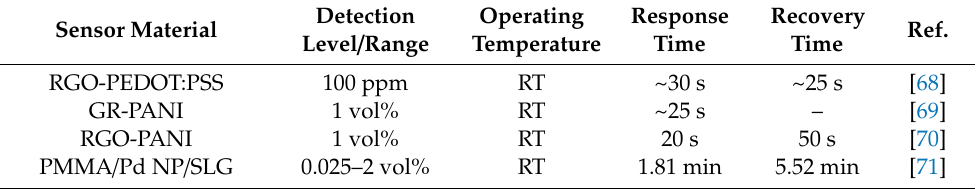
Table 1. Comparison of the H 2 sensors based on graphene and their composites with polymers. Detection Operating Sensor Material Level / Range